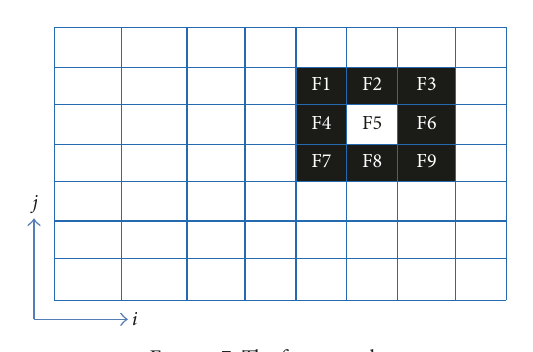
Figure 7: The fuzzy